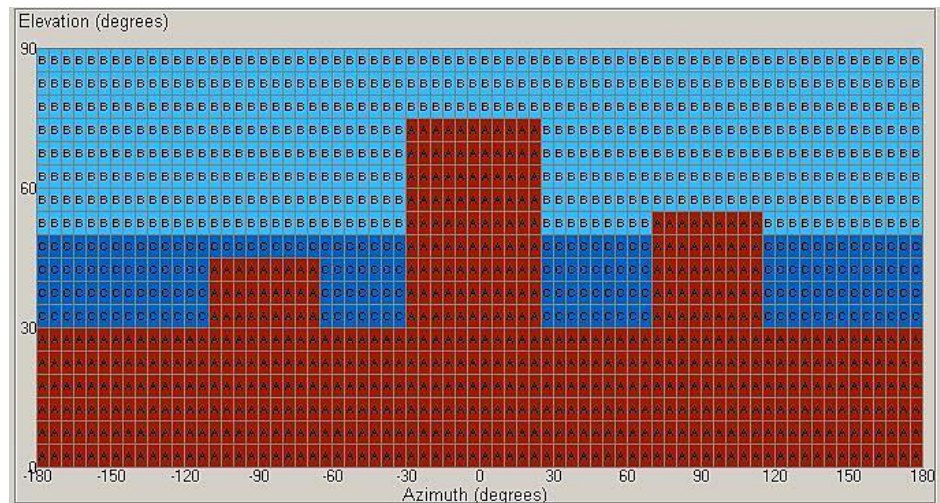
Figure 5. A simulated urban canyon environment in the Spirent GPS signal simulation.